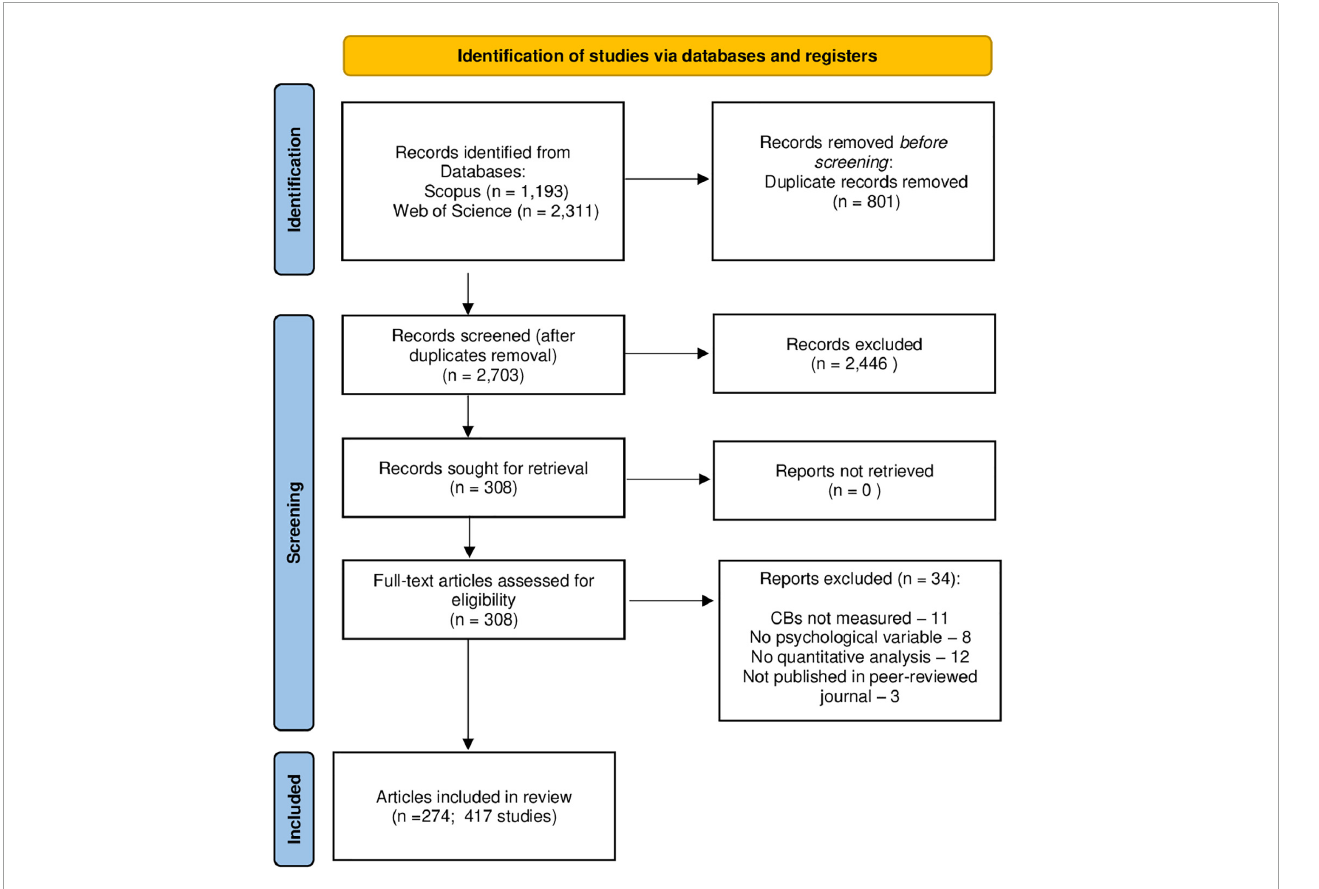
FIGURE1 PRISMA flow diagram for the current systematic